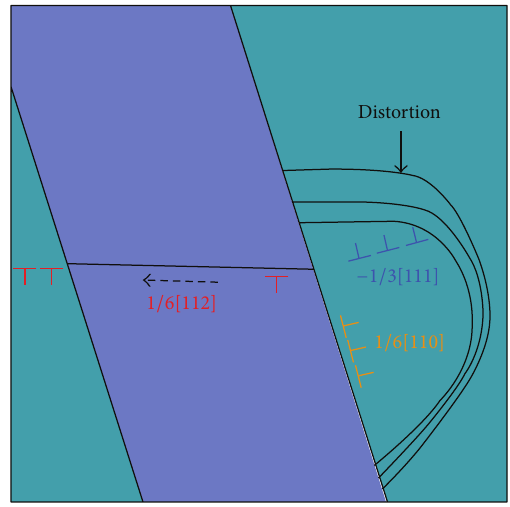
Figure 3: A schematic illustration of the reaction and movement of dislocations.